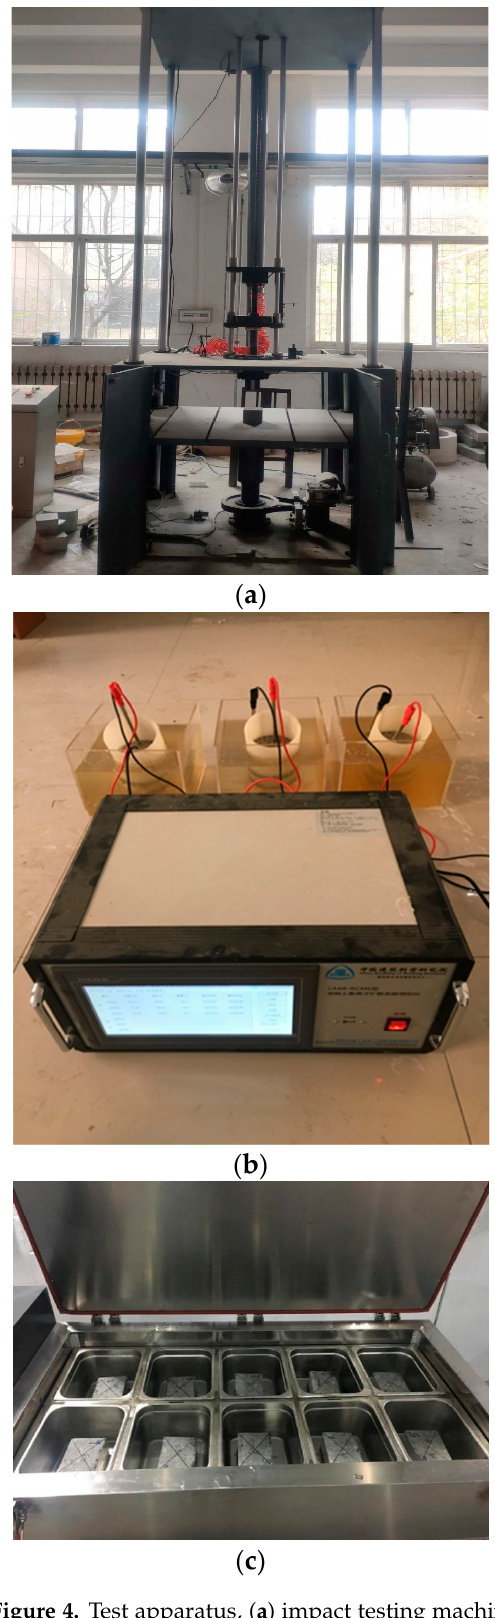
Figure 4. Test apparatus, ( a ) impact testing machine, ( b ) Test device for rapid chloride migration (RCM) method, ( c ) Single-sided freezing–thawing test.